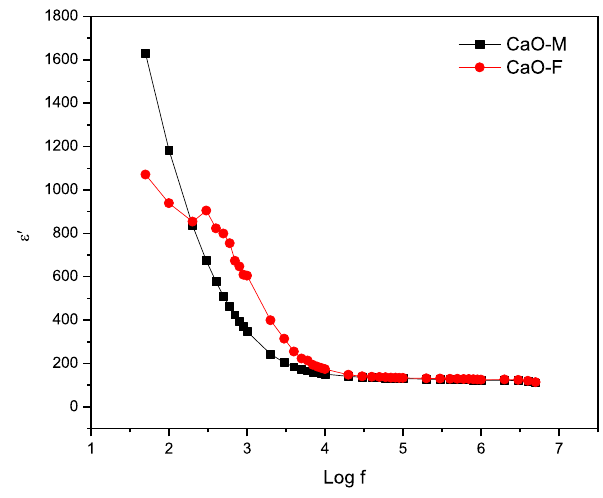
Fig. 6 Variation of A.C. Conductivity (σ ) with the frequency for ac CaO-M and CaO-F Fig. 7 Variation of dielectric constant (ε ′ ) with frequency for CaO-M and